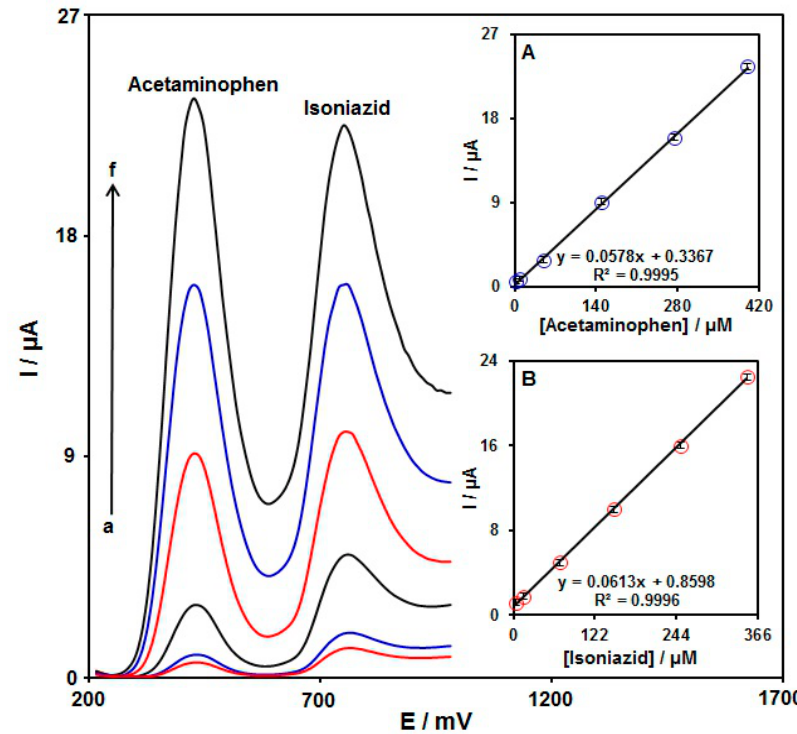
Figure 9. The DPVs of MoS 2 NSs-SPE in PBS (0.1 M, pH = 7.0) with various levels of AC and INZ; a–f: 2.5 µM + 2.5 µM, 7.5 µM + 15.0 µM, 50.0 µM + 70.0 µM, 150.0 µM + 150.0 µM, 275.0 µM + 250.0 2.5 µ M + 2.5 µ M, 7.5 µ M + 15.0 µ M, 50.0 µ M + 70.0 µ M, 150.0 µ M + 150.0 µ M, 275.0 µ M + 250.0 µ µM, and 400.0 µM + 350.0 µM of AC and INZ, respectively. Inset ( A ): the Ipa plot vs. AC concentration. Inset ( B ): the Ip plot vs. INZ concentration.